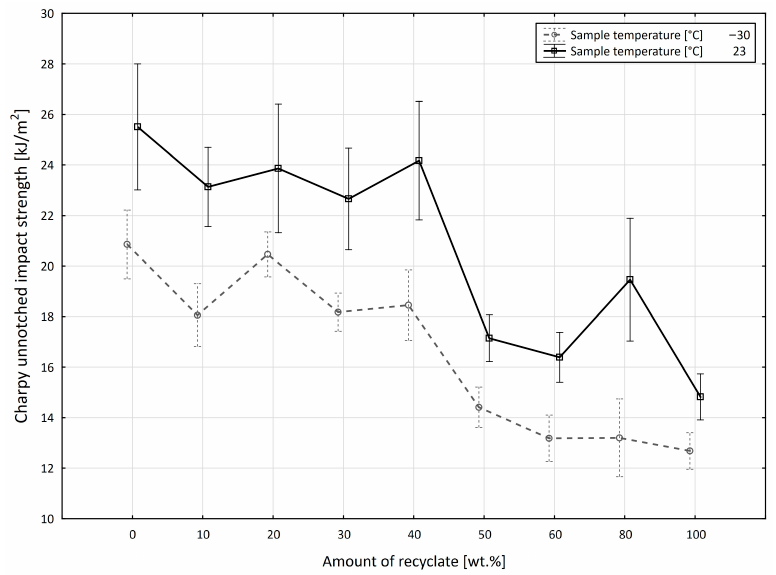
Figure 10. Dependence of the mutual interaction of the amount of recyclate and the temperature of the sample on the value of the unnotched impact strength of PPA.